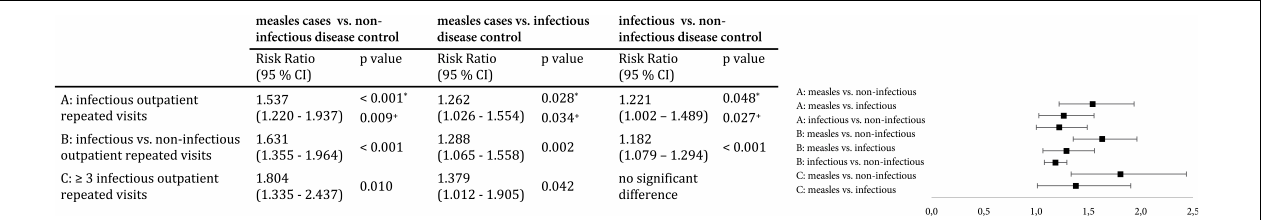
FIGURE 2 | Risk ratio for repeat visits to the emergency room due to infections. (A) Relative risk of cases for an outpatient repeat visit with an infectious diagnosis, calculated using the Man-Whitney-U test (regarding only patients with repeat visits). (B) Relative risk of cases for an outpatient repeat visit with an infectious diagnosis compared to a non-infectious diagnosis, calculated using the Chi-Square Test. (C) Relative risk of cases for three or more infectious outpatient repeat visits, calculated using the Chi-Square Test.